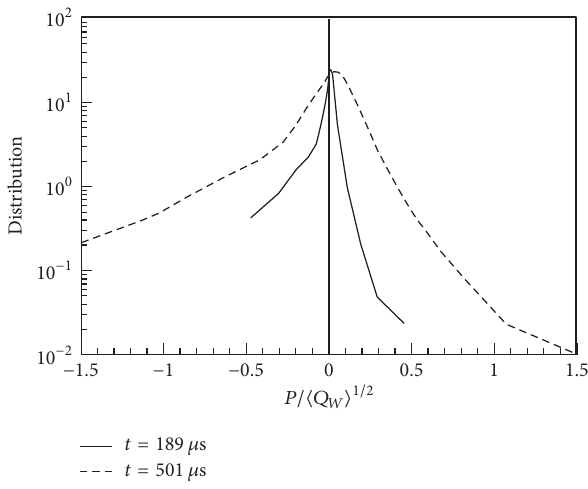
Figure 5: Probability distribution of dimensionless 𝑃 value.